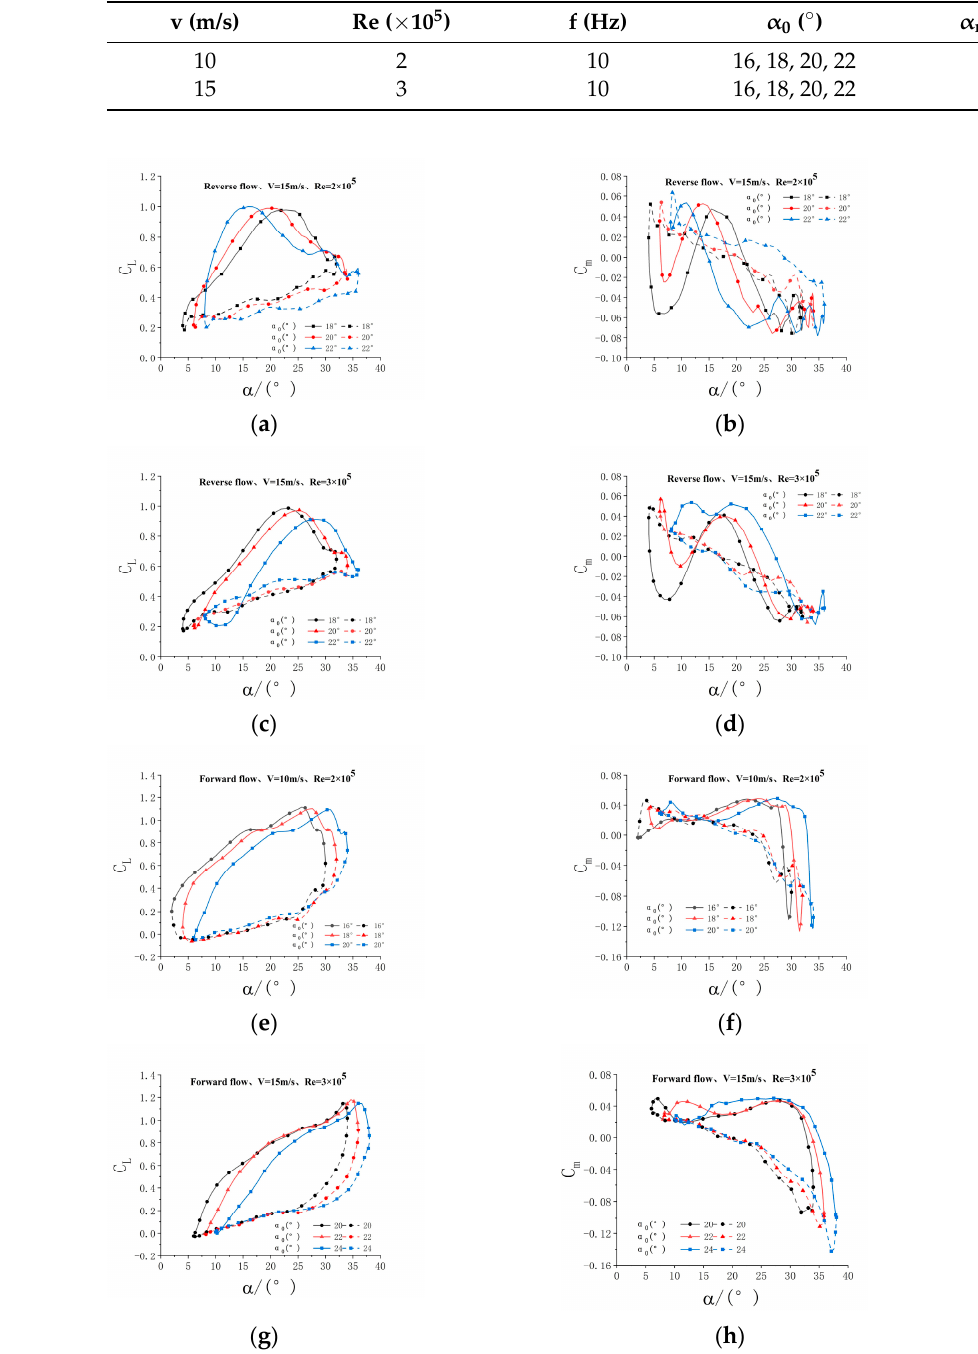
Table 7. Experimental conditions of changing the mean angle of pitch at different Reynolds numbers.